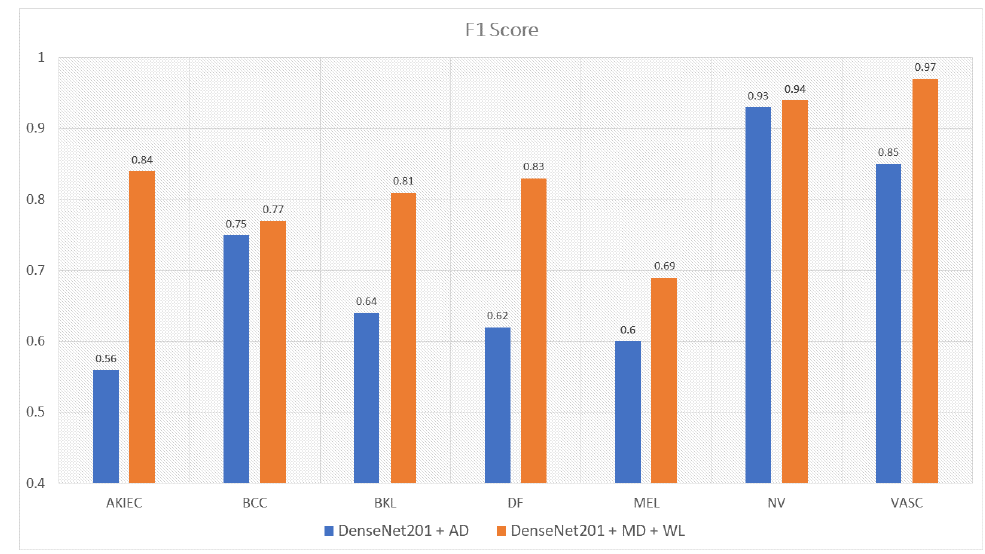
Figure 12. The comparison between F1-scores of DenseNet201 trained with augmented data and the one trained with metadata and weight loss.